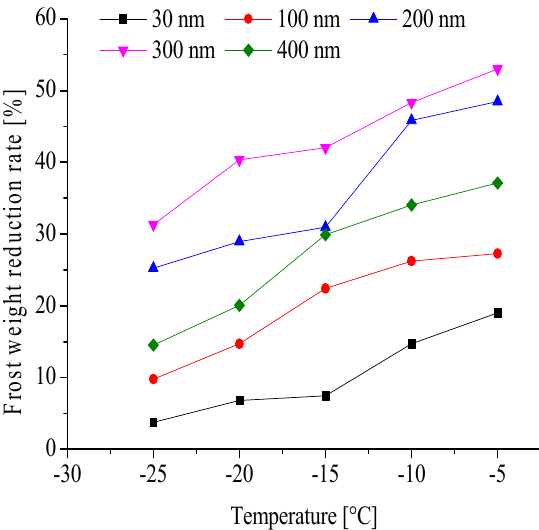
Figure 15. Variations of frost weight reduction rate of the nanoporous diameter aluminum plates compare to the polished aluminum plates at φ = 60%.